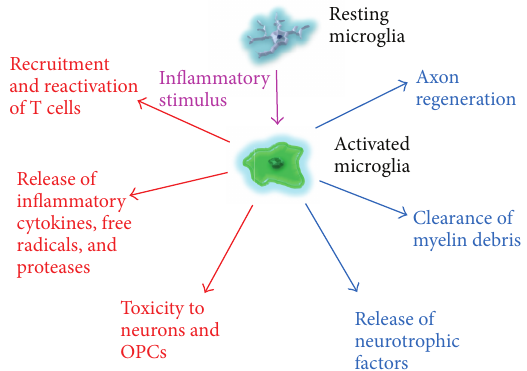
Figure 1: The dichotomy of macrophages/microglia is displayed. Macrophages/microglia have been shown to recruit and reactivate T cells in the CNS and release many detrimental molecules such as proteases, inflammatory cytokines, and free radicals. Through the latter molecules and other mechanisms, macrophages/microglia have been reported to contribute to toxicity to neurons as well as oligodendrocyte precursor cells. Conversely, they have also been observed to aid in axonal regeneration and remyelination as well as assist in the clearance of inhibitory myelin debris. In addition, macrophages/microglia have been shown to release a variety of neurotrophic factors. It can therefore be seen that macrophages/microglia possess an array of detrimental and bene- ficial functions, with the balance being dictated by the temporal and spatial specifications following CNS